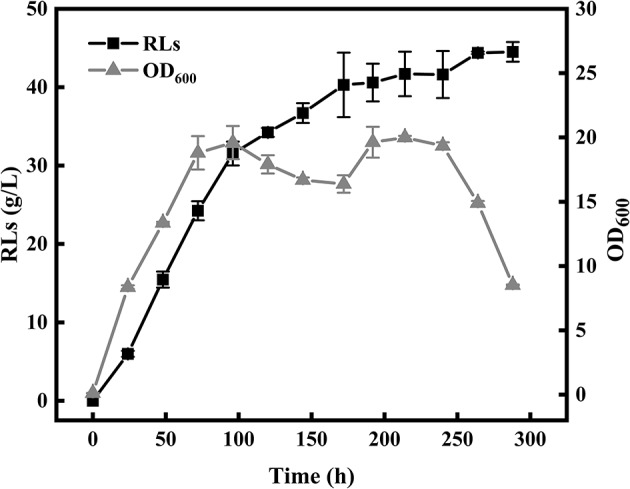
Bioreactor fermentation for rhamnolipid production.